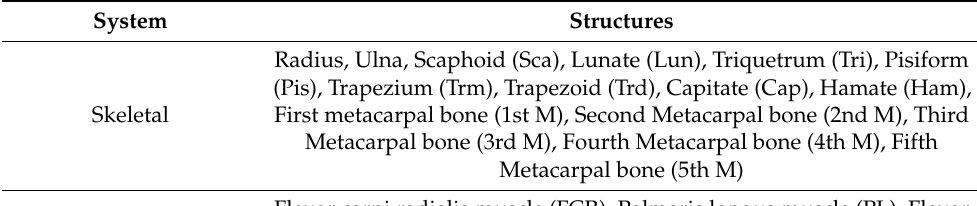
Table 1. Labeled structures in sectioned images and US images.